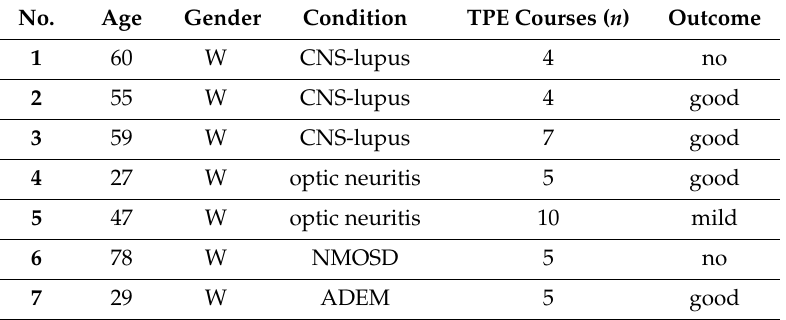
Table 3. TPE in patients with other immune-mediated disorders of the central nervous system (CNS) .